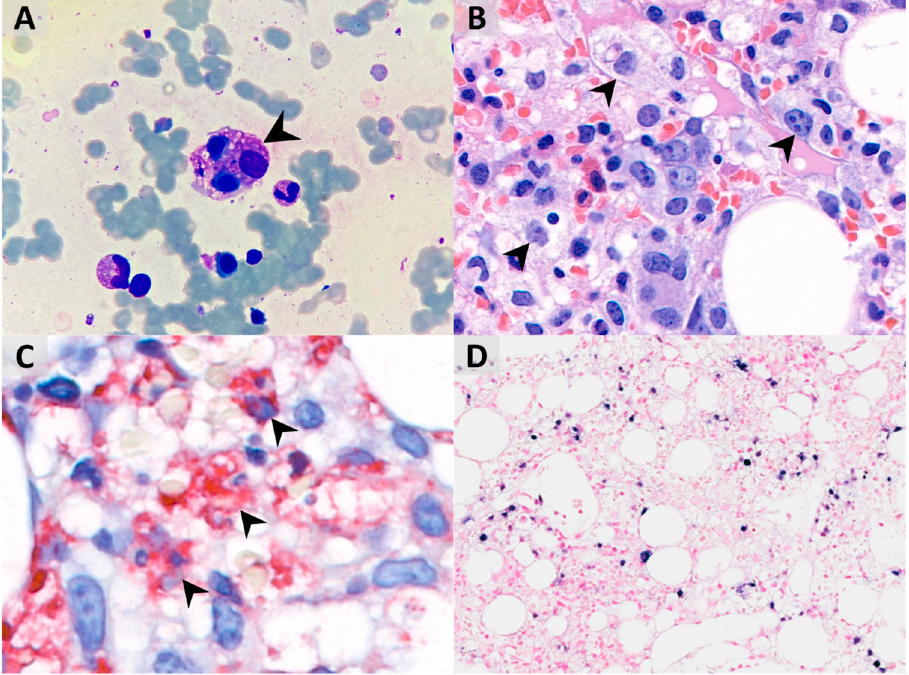
Figure 2. ( A ) Bone marrow aspirate smear shows hemophagocytosis of normoblasts (indicated by arrowheads, Liu’s stain, 1000× magnification). ( B ) Bone marrow biopsy shows significantly in- creased foamy histiocytes, which seem to phagocytize other cells (hematoxylin and eosin (H&E) stain, 800× magnification). ( C ) Hemophagocytic histiocytes are highlighted by the CD68 immuno- histochemical stain with red cytoplasmic staining (1000× magnification). ( D ) Some lymphocytes are positive for the EBER in situ hybridization and show nuclear dark-purple staining (200× magnifica- tion).